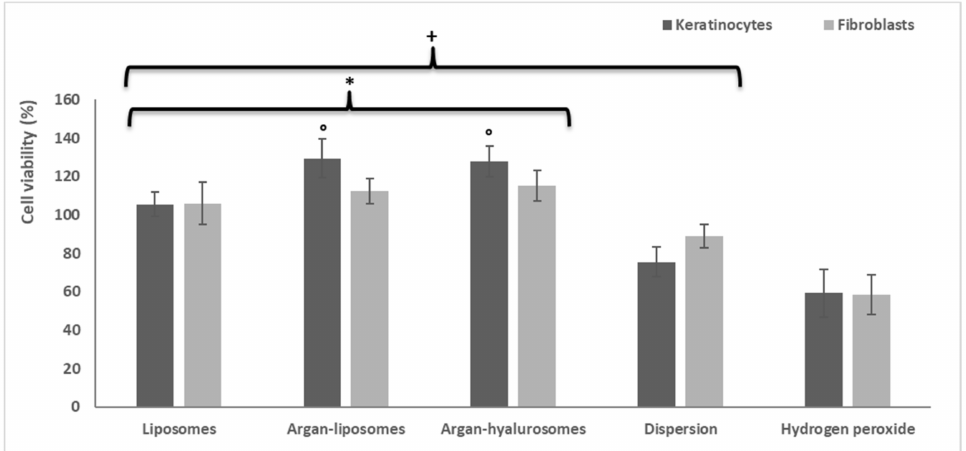
Figure 7. Protective effect of neem oil formulations under oxidative stress induced with hydrogen peroxide in keratinocytes and fibroblasts. Symbol (+) indicates values significantly different from that of cells stressed with hydrogen peroxide ( p < 0.05); symbol (*) indicates values significantly different from that of cells treated with neem oil dispersion ( p < 0.05) and symbol ( ◦ ) indicate values significantly different from that of cells treated with liposomes.